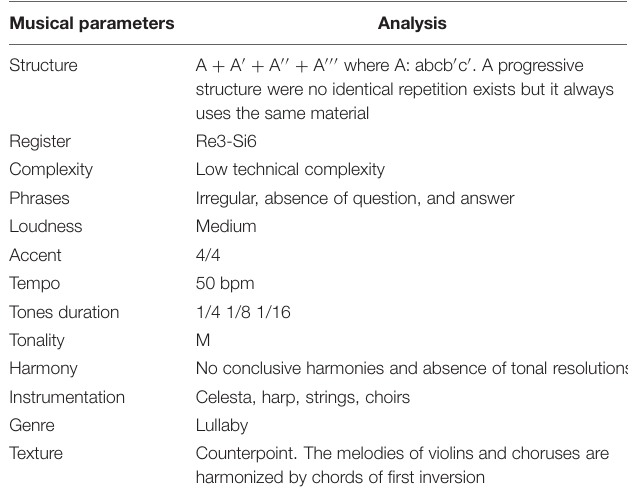
TABLE 2 | Summary of the specific musical parameters used to develop a relaxing and sedative musical